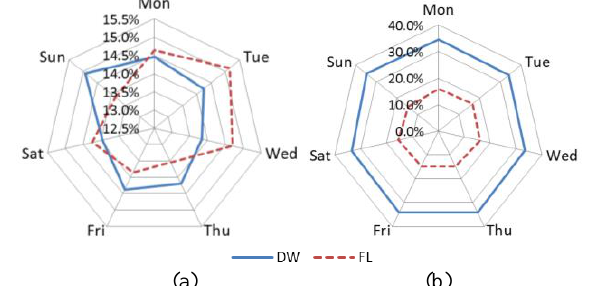
Figure 7. Weekly variations: (a) proportion to each type of fire;